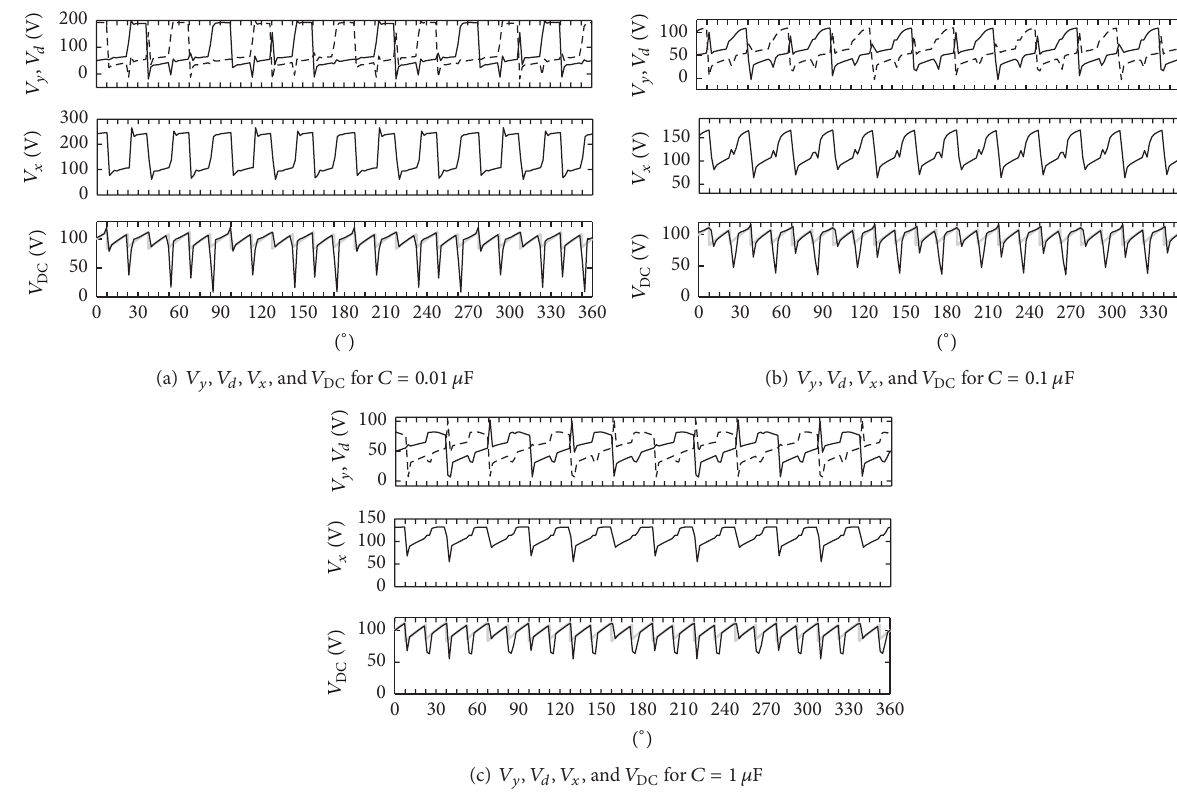
Figure 14: Simulated Reinjection current and DC side voltage waveforms for the 3-level thyristor based MLCR CSC.